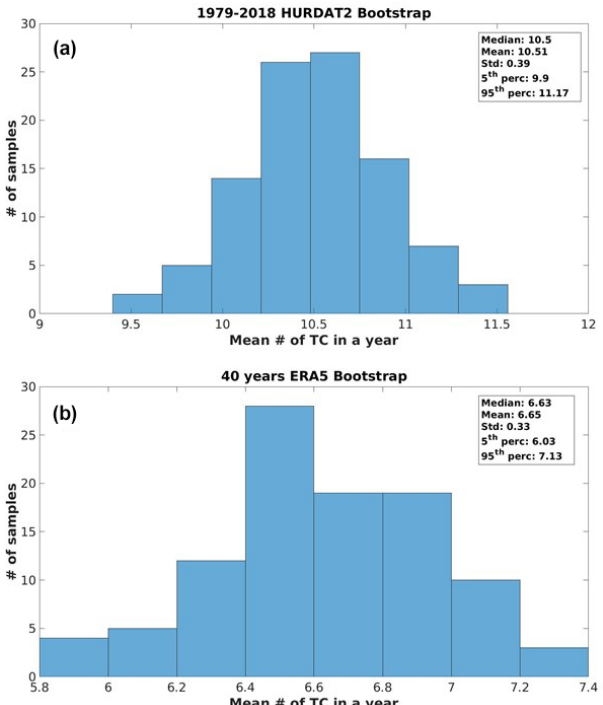
Figure 5. Bootstrap distributions based on (a) the 1979–2018 HURDAT database and (b) 1979–2018 ERA5 reanalysis data. The legend presents the median, mean, standard deviation, 5th and 95th percentiles of the